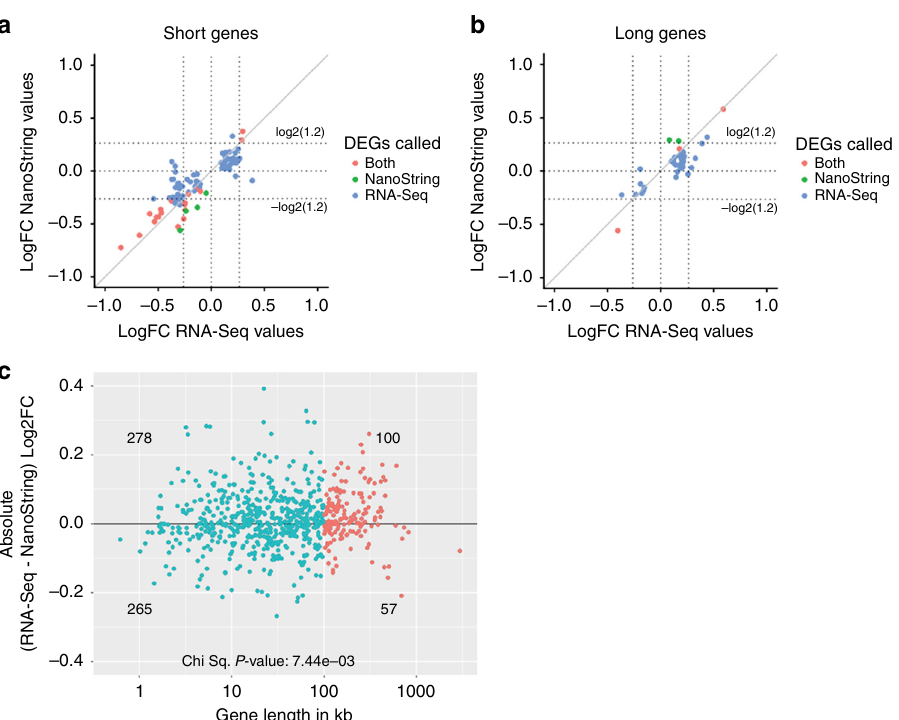
Fig. 5 Expression changes are overestimated in RNA-seq datasets. Comparison of log fold-change in expression between RNA-seq ( n = 3 each) and NanoString ( n = 3 each) for short genes ( a ) and long genes ( b ). Genes were considered to be differentially expressed if FDR < 0.05. Red dots indicate genes found to be differentially expressed in both platforms. The green and blue dots indicate genes that are only found to be differentially expressed in either the NanoString or the RNA-seq dataset, respectively. The dashed lines in ( a , b ) on x -axis and y -axis correspond to log 2 fold change of − log 2 (1.2), log 2 (1), and log 2 (1.2). c Absolute log fold-change difference between RNA-seq and NanoString ( y -axis) plotted against gene length ( x -axis). Red dots are long genes, and blue dots are short genes. P values were computed using a chi-square test. See Supplementary Fig. 10 for additional analyses related to this